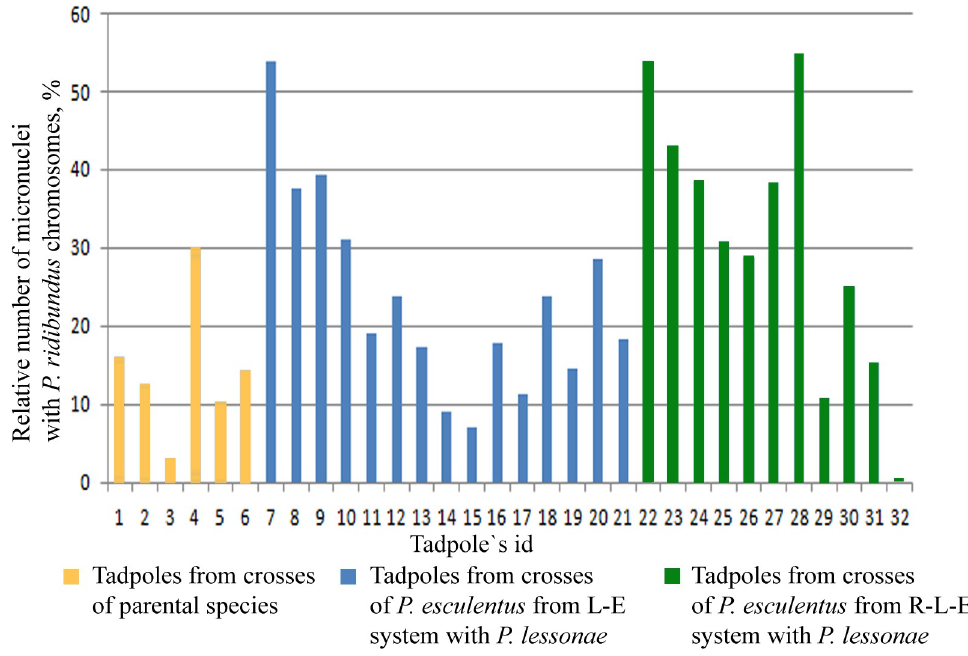
Fig 4. Relative number of micronuclei bearing P . ridibundus chromosomes in hybrids obtained from various crosses.